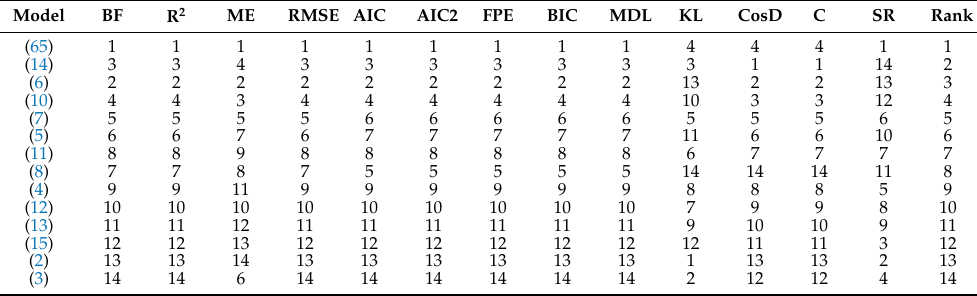
Table 9. Model selection metrics